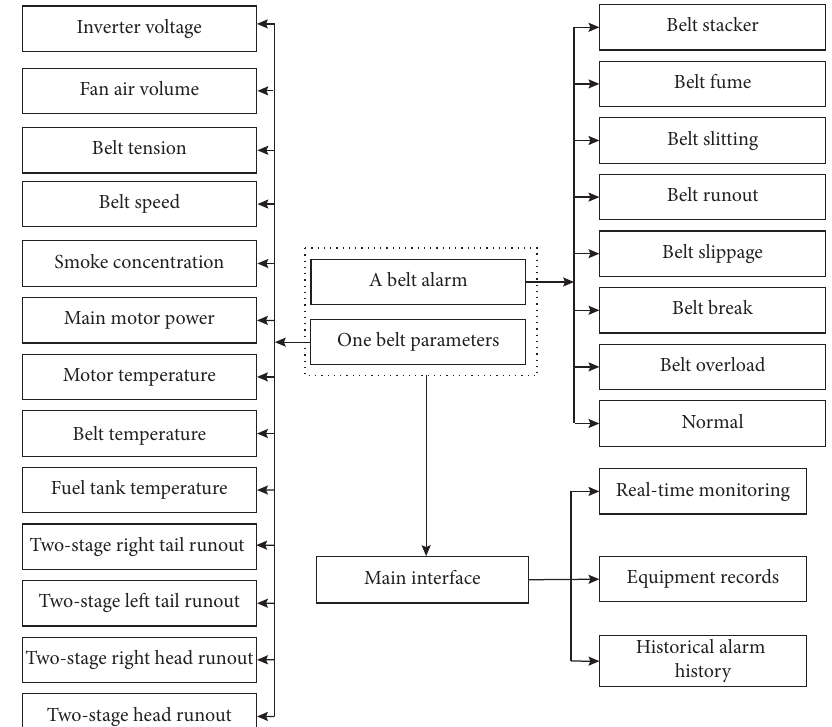
Figure 4: Belt conveyor health condition monitoring system